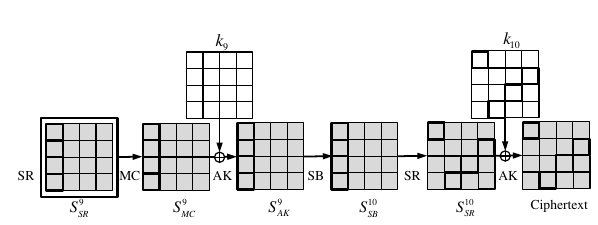
Figure 14: Motivating Example: Key Extraction in Impossible